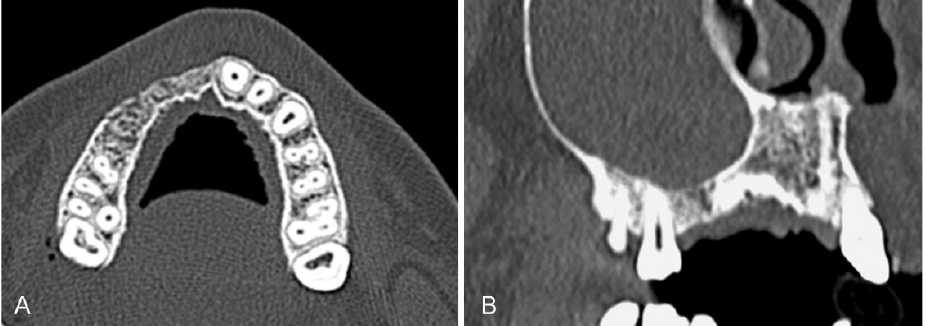
Figure 2. Dental CT-Scan at four months after trauma. Axial ( A ) and sagittal ( B ) CT-images (Images: Institute of Radiology, Kantonsspital Aarau, AG, Aarau,